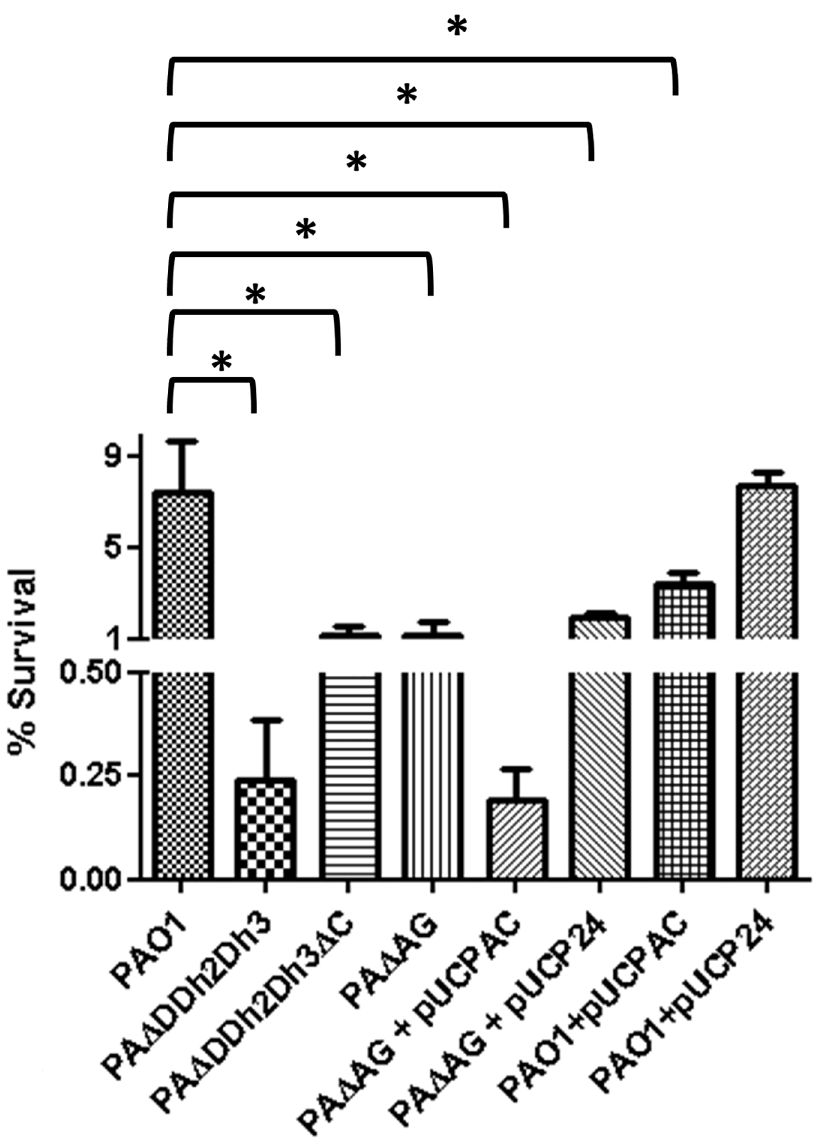
Fig 6. Bactericidal activity of PGRP2 + colistin treatment in PAO1 and derived peptidoglycan recycling defective / AmpC hyper-expressing strains. The percentages of bacterial survival after treatments respect to the initial inoculumare shown. The bars represent the mean of 5 experiments and the error bars the SD; * Statistically significant, P < 0.001in the One-way ANOVA with post hoc Tukey’s multiple comparisontest. PA Δ DDh2Dh3: knockout mutant on ampD , ampDh2 and ampDh3 genes; PA Δ DDh2Dh3 Δ C: knockout mutant on ampD , ampDh2 , ampDh3 and ampC genes. PA Δ AG: knockout mutant on ampG . pUCPAC: pUC18-based Escherichia-Pseudomonas shuttle vector containing PAO1 AmpC gene. pUCP24: empty pUC18-based Escherichia-Pseudomonas shuttle vector.